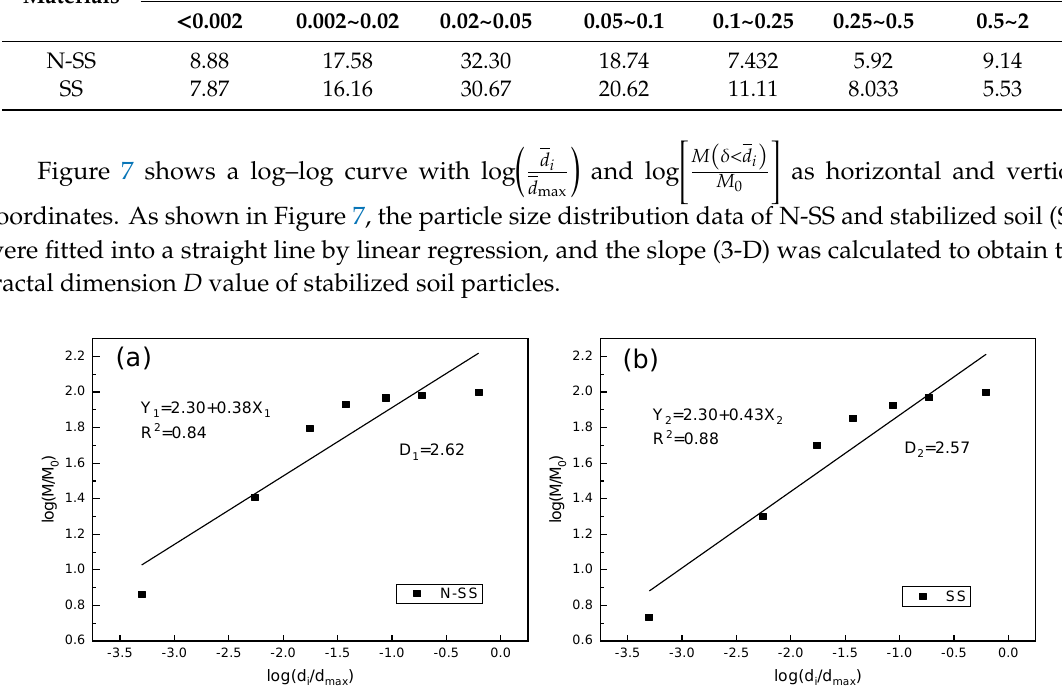
(cid:17) . ( a ) N-SS; ( b )